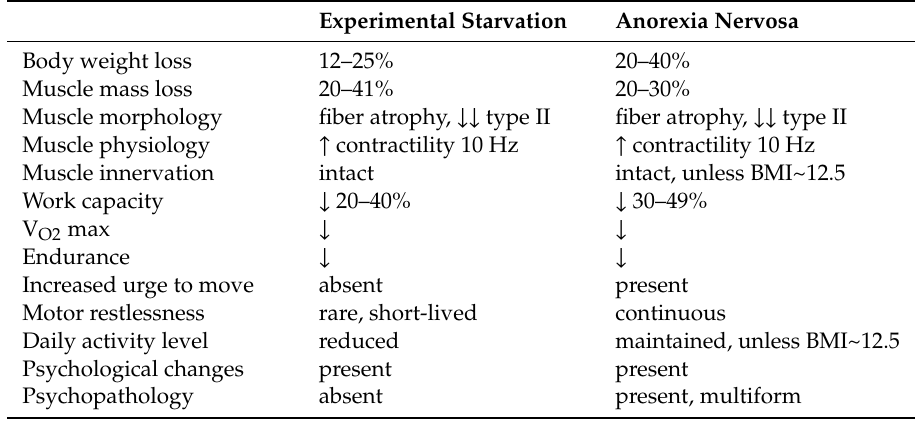
Table 1. Loss of muscle mass and adjustments in muscle morphology and muscle physiological function in underweight individuals with anorexia nervosa were found to be similar to the adaptations in muscle in response to experimental long-term starvation in healthy young adult